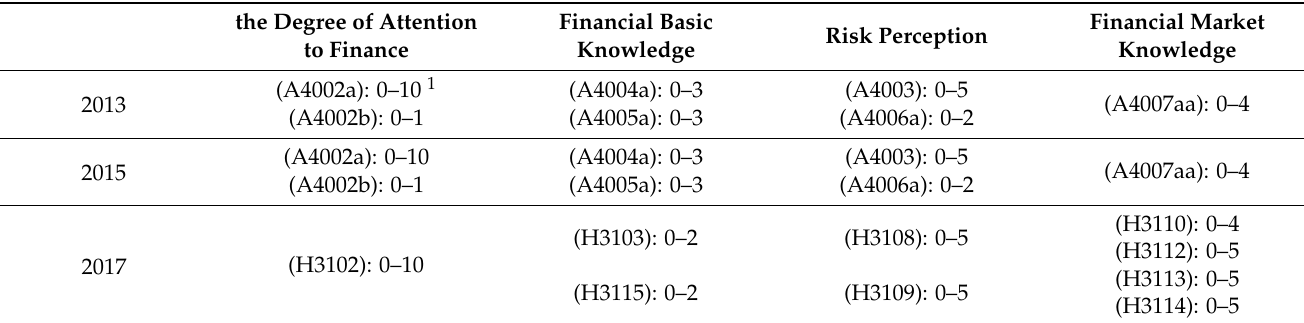
Table 1. Financial cognitive ability measurement